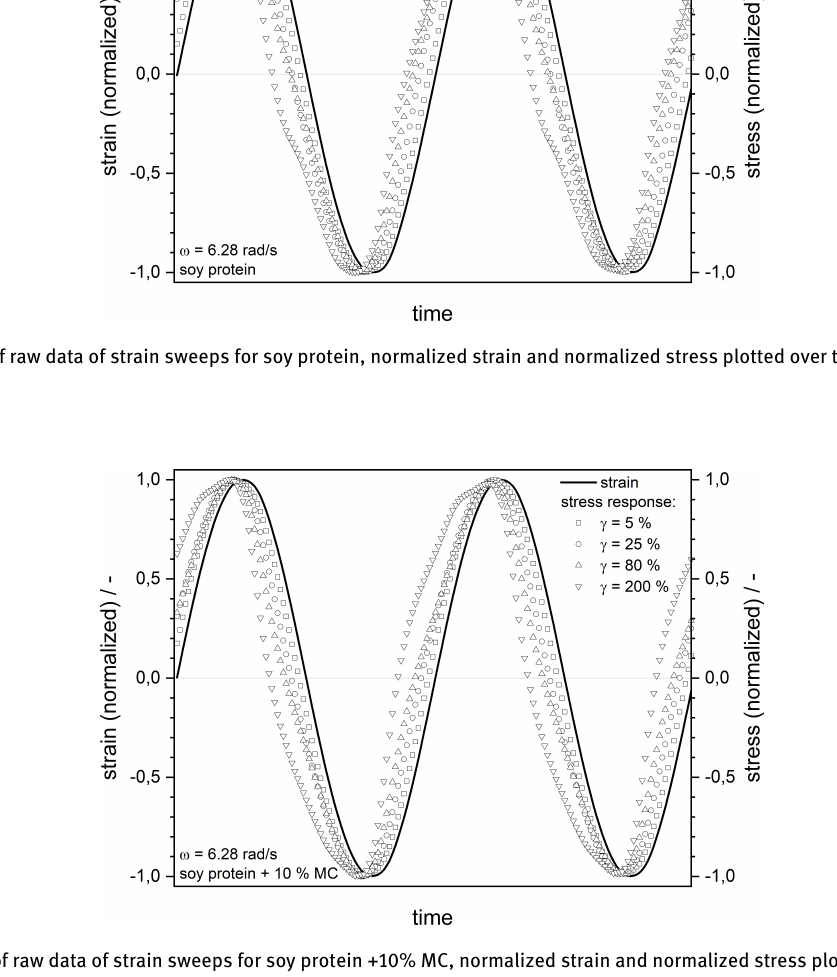
Figure A2: Excerpt of raw data of strain sweeps for soy protein +10% MC, normalized strain and normalized stress plotted over